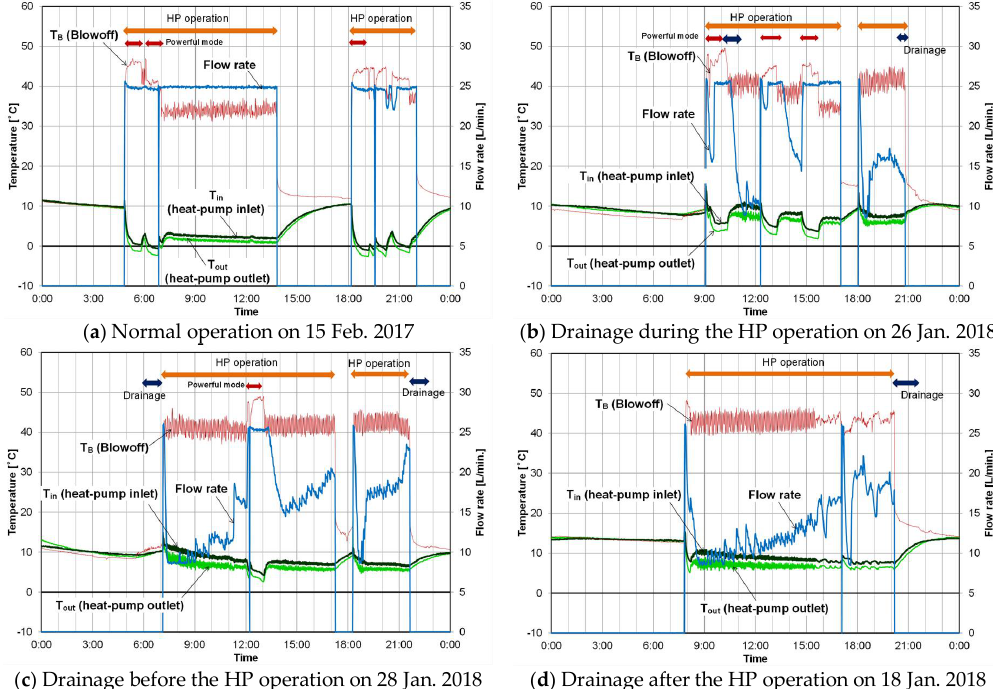
Figure 7. Antifreeze solution temperature and flowrate change in each operation